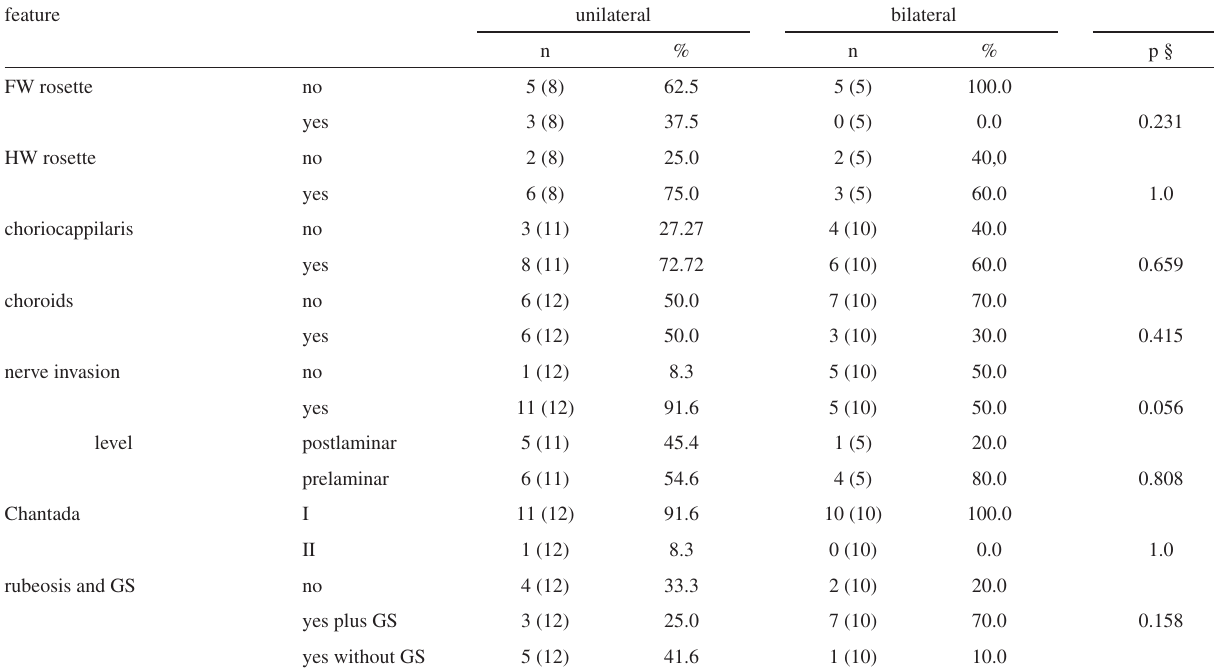
Table 5 - Anatomopathologic characteristics. Not all features were described in each anatomic piece so, the “n” is variable feature